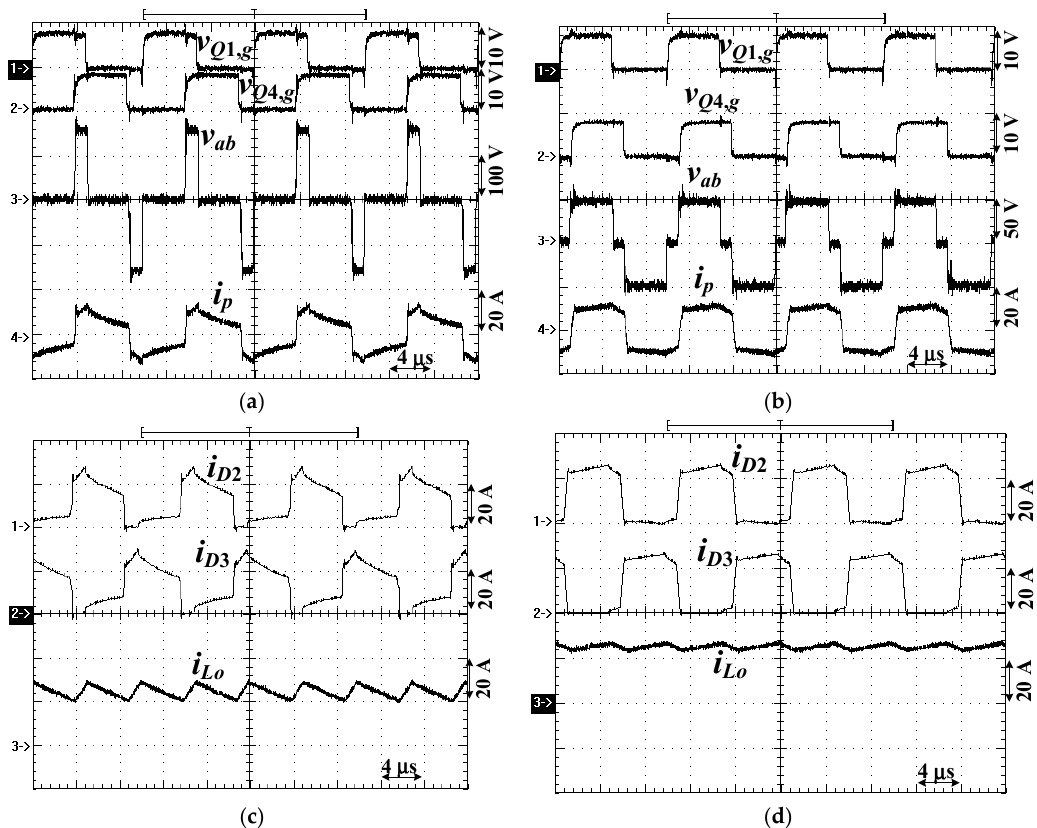
Figure 10. Experimental results in high input voltage range and full load ( a ) primary side waveforms at 150 V input ( b ) primary side waveforms at 50 V input ( c ) secondary side waveforms at 150 V input ( d ) secondary side waveforms at 50 V input.